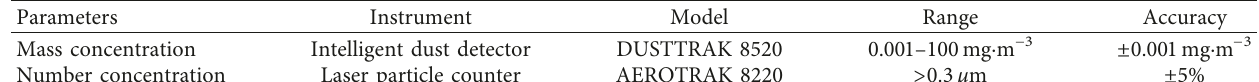
Table 1: Measurement parameters and measuring instruments.